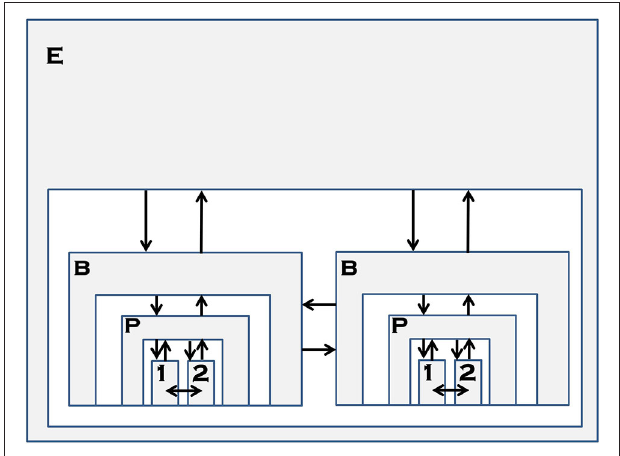
FIGURE 3 | A dynamic representation of social cognition highlighting interdependency and reciprocal influence across the regions of the nervous system associated with Type 1 or Type 2 processes, personal-level experiences (P), bodies (B), and their coupling with each other and the (E) environment (Adapted from the work of Beer, 2000; Bohl and van den Bos, 2012; Froese et al., 2013)